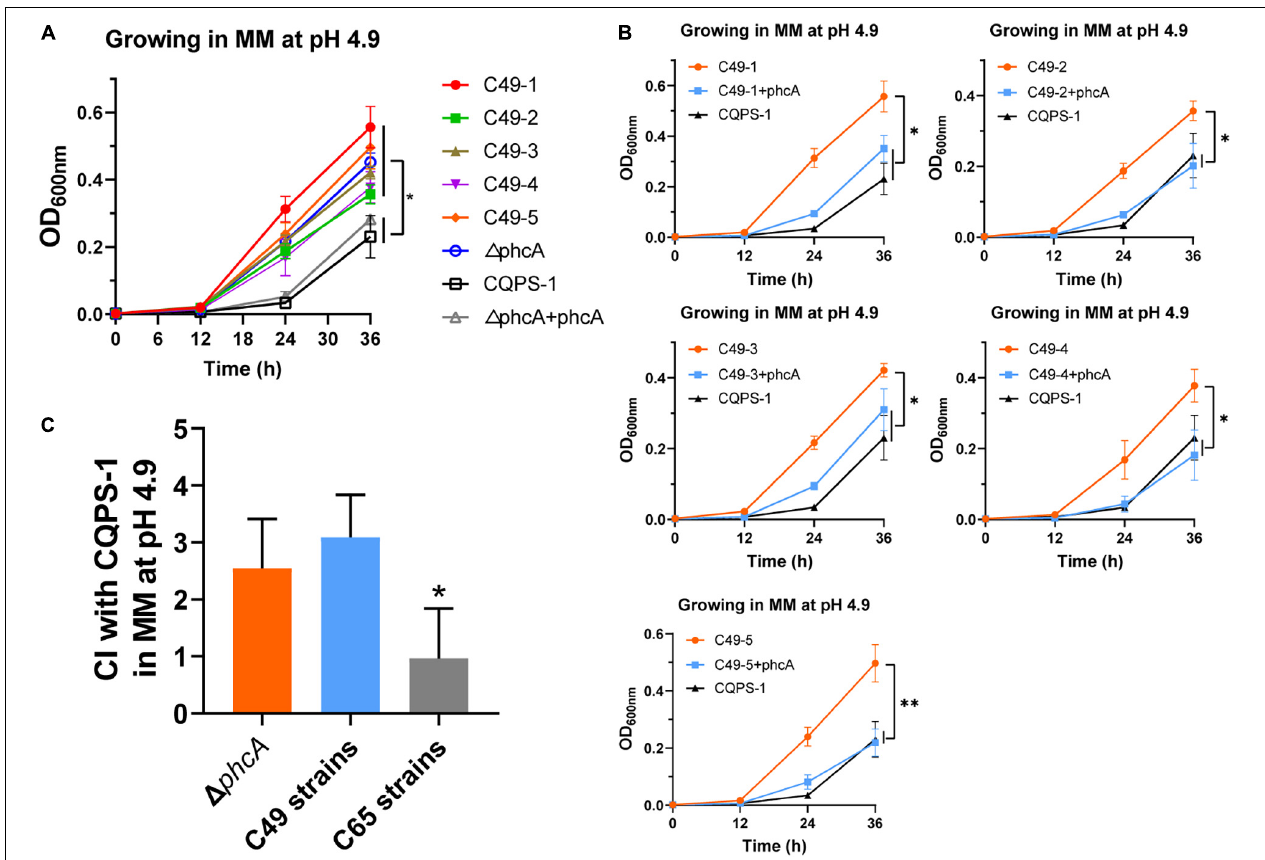
FIGURE 5 | Growth curves and competition experiments of the phcA deletion mutant, C49 strains and the wild-type strain. (A) Growth curves of the phcA deletion mutant, C49 strains and the wild-type strain in MM medium at pH 4.9. (B) Growth curves of C49 strains after expressing an intact phcA gene by the complementary experiment. (C) The mean competitive index (CI) values of the phcA deletion mutant, acid-evolved clones, and control C65 clones relative to the wild-type CQPS-1 growing in MM medium at pH 4.9. The five selected clones of experimental C49 strains or C65 strains were used in the experiments. Asterisks indicate statistical significance (unpaired t -test, ∗ p < 0.05 or ∗∗ p < 0.01).